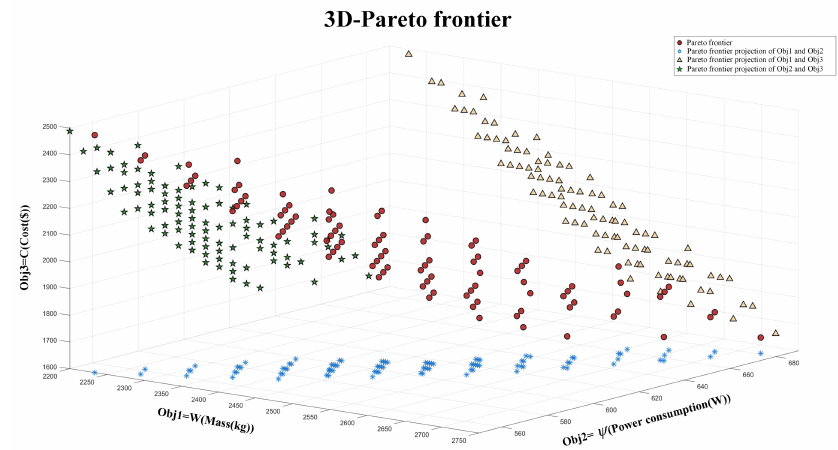
Figure 11. 3D-Pareto frontier of multi-objective optimization of MECS.